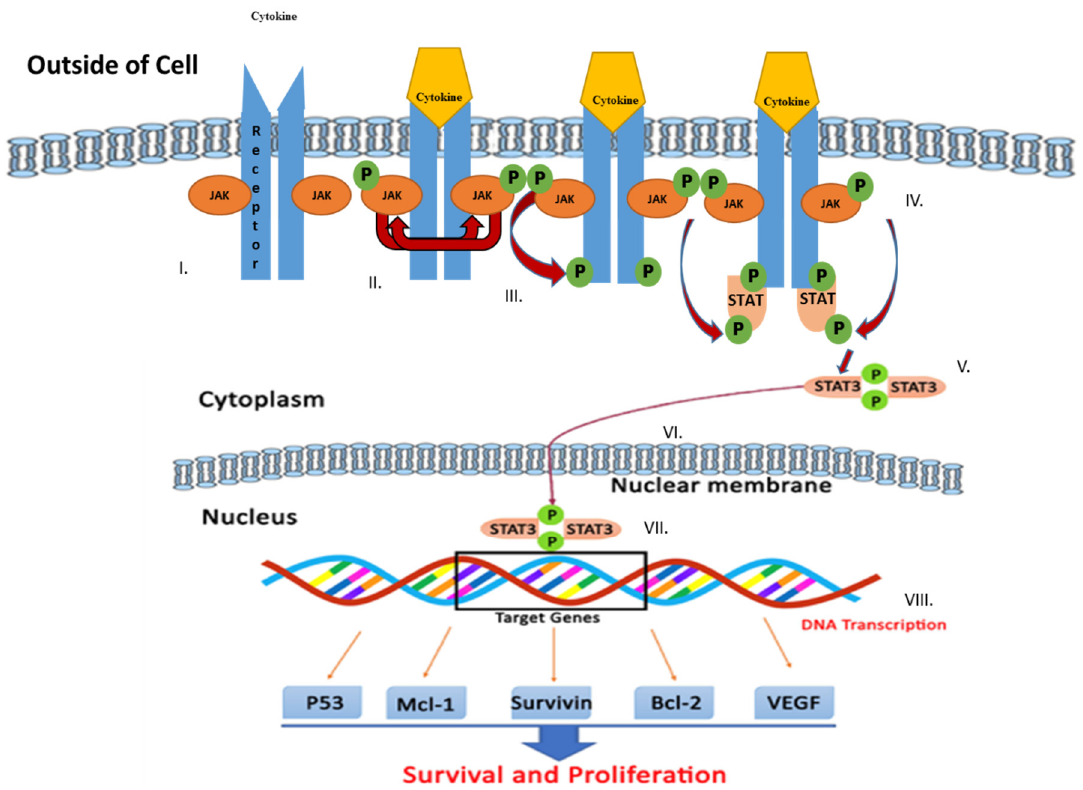
Figure 1. Schematic representation of Janus kinase (JAK)/signal transducer and activator of transcription (STAT) signaling pathway activation leading to upregulation of genes involved in survival and tumor cell proliferation. Various steps in the JAK/STAT pathway: I: Cytokine binds to the receptor and receptors dimerize. II: JAKs are phosphorylated by each other. III: JAK phosphorylates the receptor, forming phosphotyrosine binding sites for STAT’s SH2 domain. IV: STAT binds to the receptor. JAK phosphorylates STAT which changes the conformation of STAT and stimulates its release. V: Phosphorylated STAT dissociates from the receptor and dimerizes. VI: Phosphorylated STAT translocates into the nucleus. VII. Phosphorylated STAT binds to DNA. VIII. Stimulation of DNA transcription of target genes.